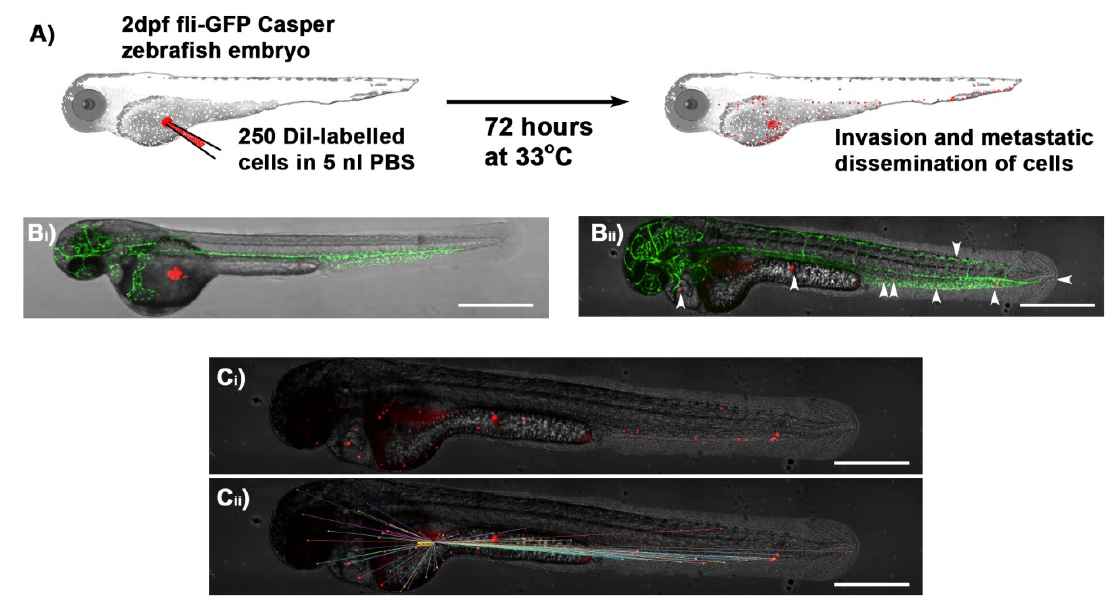
Figure 1. Schematic of xenograft assay and analysis of cell migration. A ) Site-specific injection (depicted into the yolk sac) of DiI- or RFP-labelled (Red) cancer cells in 5 nl PBS into 2 dpf zebrafish embryos is followed by incubation of zebrafish for 72 hours at 33°C and subsequent imaging analysis of invasion and metastatic dissemination of cancer cells. B ) Approximately 250 DiI-labelled A375 melanoma cells 0 hrs ( Bi ) and 72 hrs ( Bii ; white arrows indicate position of melanoma cells) after injection into the yolk sac of Tg(kdrl-GFP) Casper zebrafish (Green blood vessels). C ) Confocal z-stack images are used to visualise red DiI fluorescence of melanoma cells within zebrafish ( Ci ) and the distance from injection site measured using Volocity image analysis software ( Cii ); Scale bar = 500